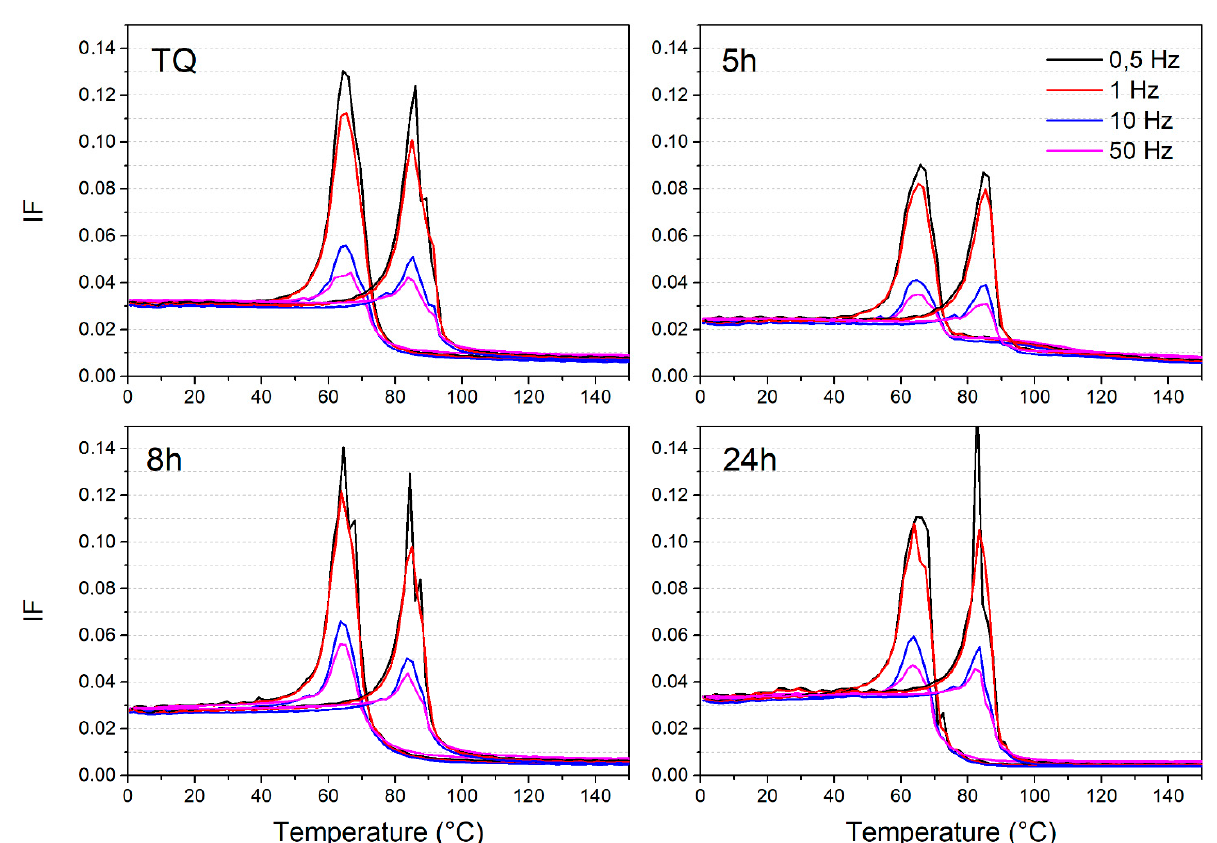
Figure 4. IF vs. temperature evolution for NiTiCu20 samples at different frequencies.